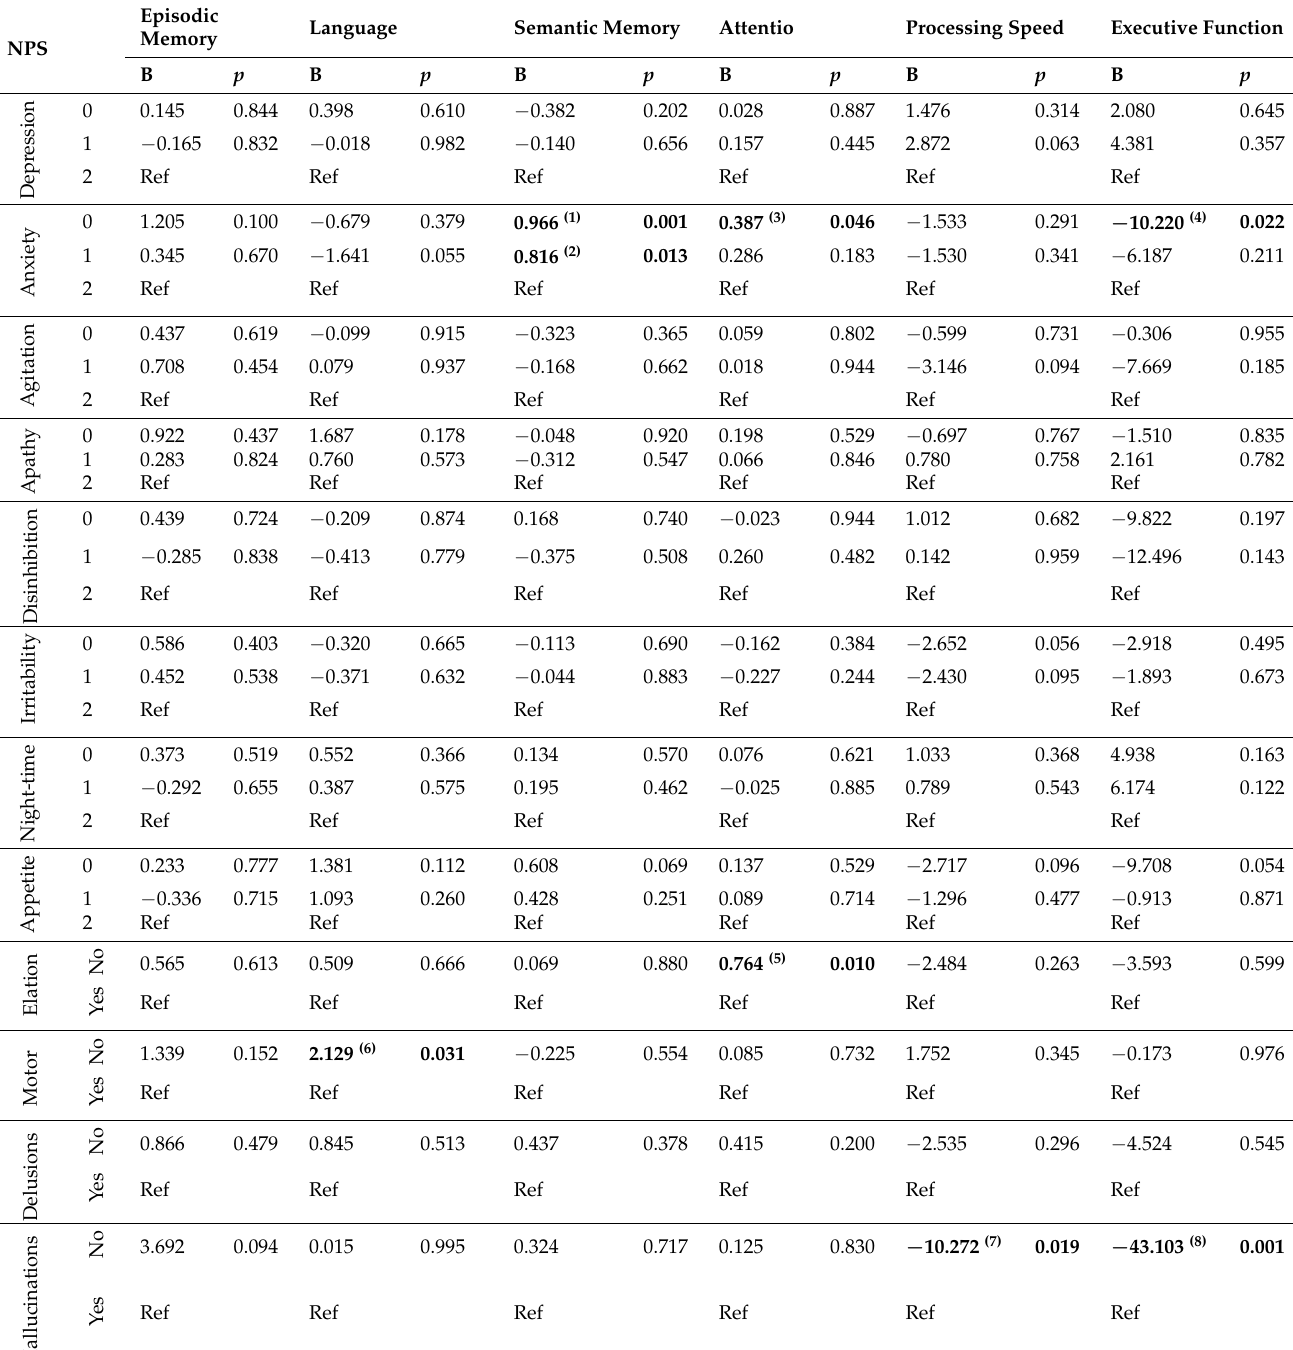
Table 2. Associations between neuropsychiatric manifestations and cognitive